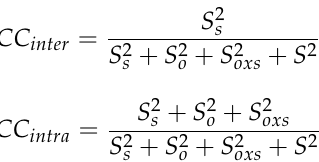
Figure 2. Schematic time intensity curve with illustration of the blood flow parameters. Peak en ‐ hancement (PE), wash ‐ in area under the curve (WiAUC), wash ‐ out area under the curve (WoAUC) , total area under the curve (AUC) , rise time (RT), mean transit time (mTTI), time to peak (TTP), wash ‐ in rate (WiR), fall time (FT), and wash ‐ out rate (WoR) .